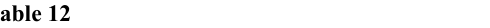
Value of Risk Analysis for Vulnerability Aspects (V)